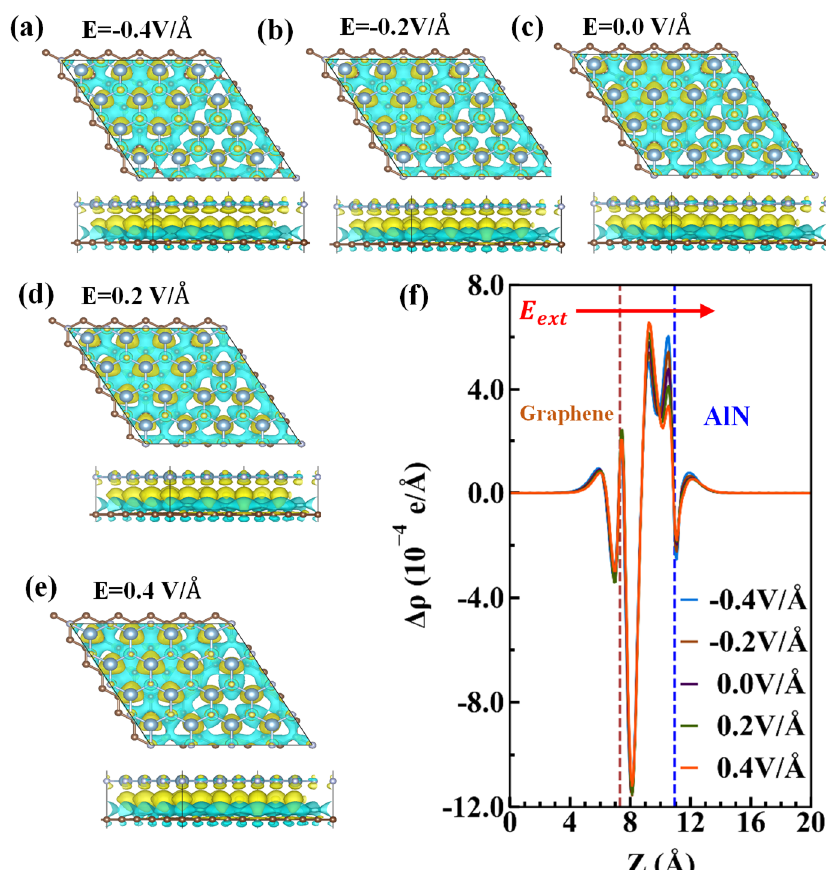
Figure 4. ( a – e ) The di ff erence charge density of the graphene / AlN system under a di ff erent external electric field. The iso-surface was set to 3 × 10 − 4 e / Å 3 . The yellow and cyan colors represent the depletion and accumulation of electrons, respectively. ( f ) The averaged di ff erence in the electron density for the graphene / AlN heterojunction under various external electric fields, the location of graphene, and the AlN sublayer are marked as brown and blue dashed lines, respectively. The positive external field direction is denoted by a red arrow.